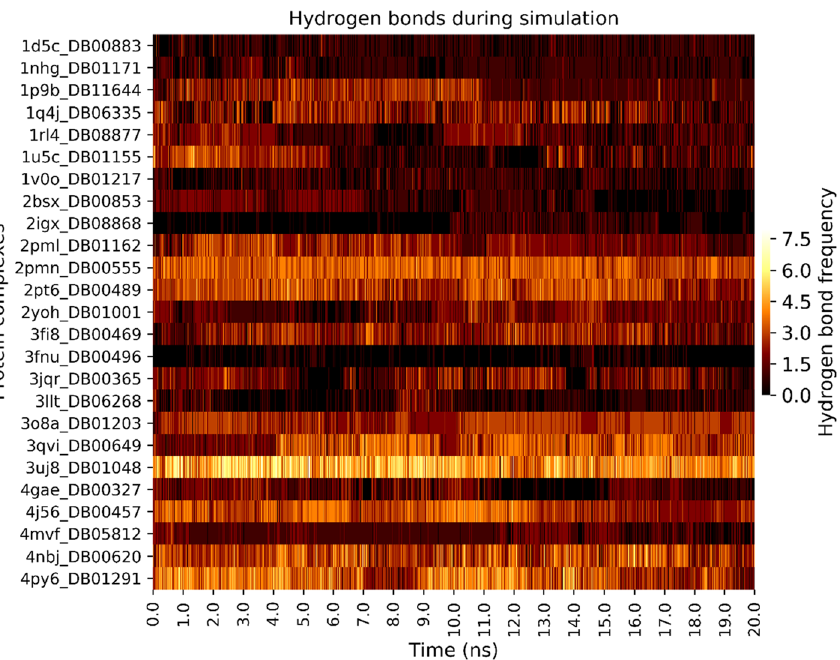
Figure 6. Hydrogen bonds between the protein and the ligand during the 20 ns simulation. Complexes are represented on the y-axis with the PDB ID and DrugBank IDs. The heatmap was generated using Seaborn version 0.9 85